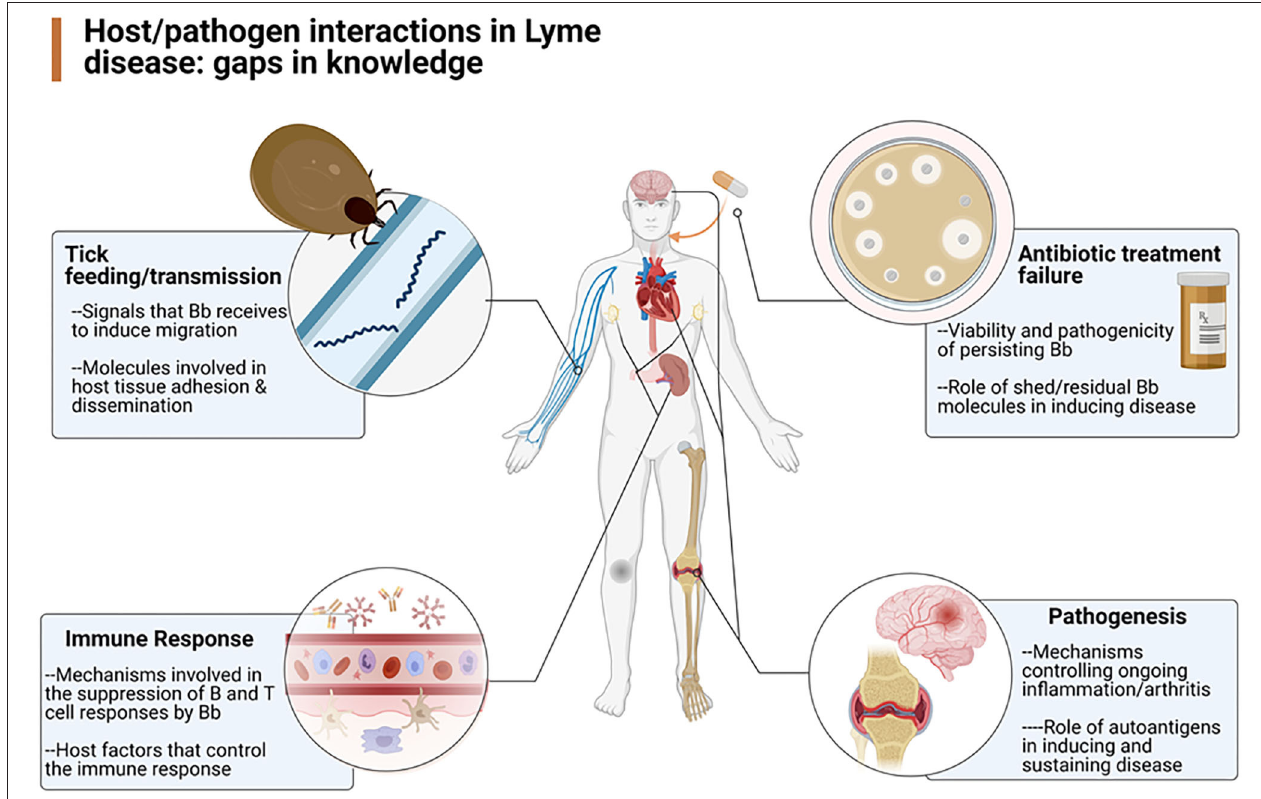
FIGURE 1 | Overview of the gaps in knowledge defined by the working group as areas in need of further research (Created by